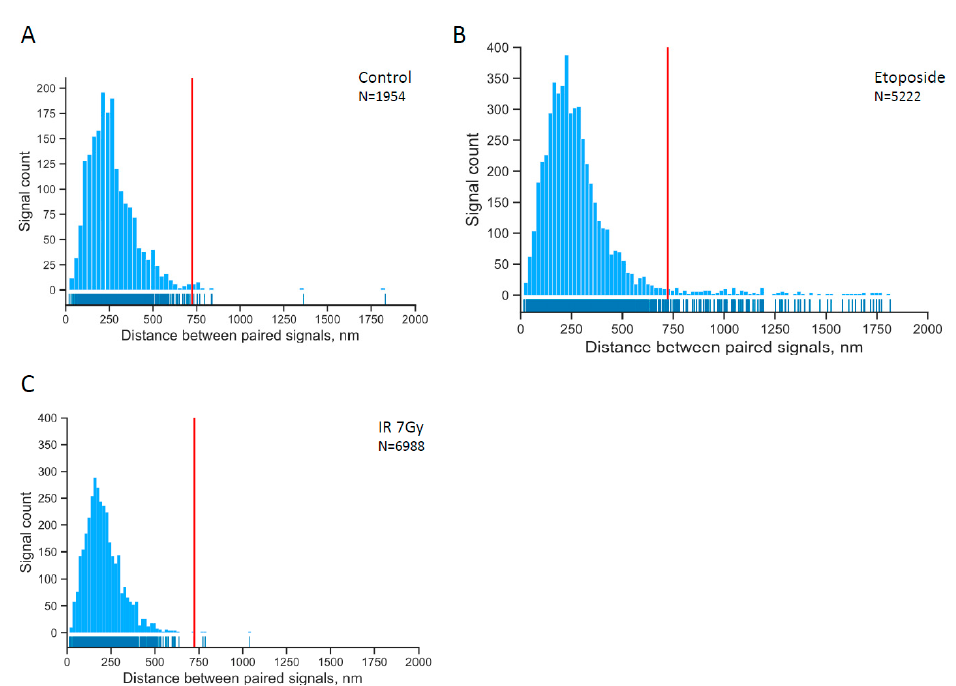
Figure 2 . The distribution of pairwise distances within paired signals in control cells ( A ), in etoposide- treated cells ( B ) and cells treated with ionizing radiation (IR) ( C ). The red line separates the 99% quantile for the control experiment. The tail on the histogram of pairwise distances of signals in etoposide-treated cells is non-random with a confidence level of 0.997 (see Statistics in the Section 4).